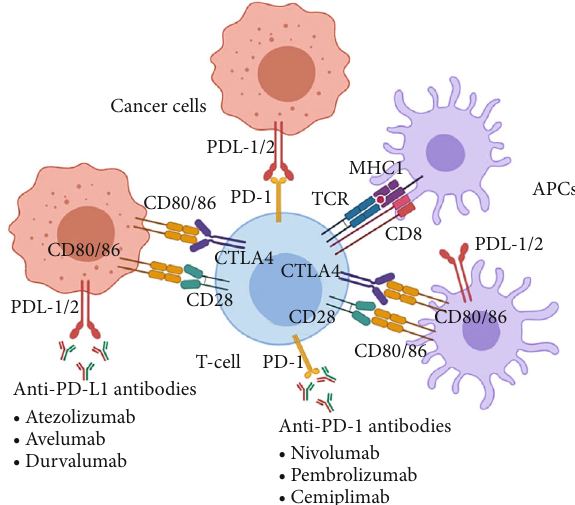
Figure 1: Mechanism of action of PD-1/L1 checkpoint